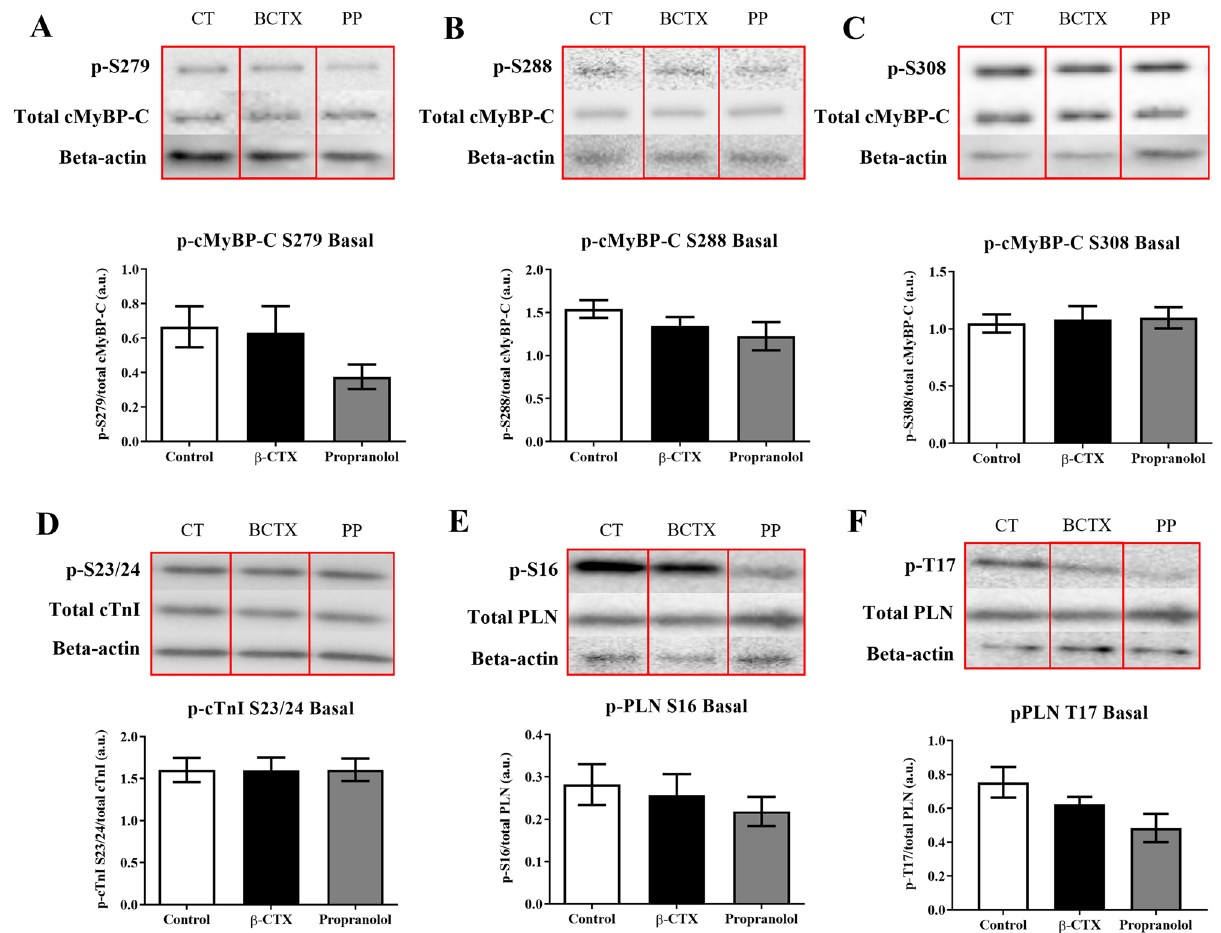
Figure 4. Comparison of specific phosphorylation sites of proteins involving in β-adrenergic signaling after incubated cardiomyocytes with control solution, β-CTX, and propranolol only (PP) (n = 6 each). The grouping of gels/blots cropped from different parts of the same gel. Uncropped blots are available in supplementary (Figure S5 and S6). Representative cropped blots are shown above their corresponding bar graphs. Data are demonstrated in mean ± S.E.M. of the ( A ) p-S279, ( B ) p-S288 and, ( C ) p-S308 of cardiac myosin binding protein-C (cMyBP-C), ( D ) p-S23/24 of cardiac troponin I (cTnI), and (G) p-S16 and (H) p-T17 of phospholamban